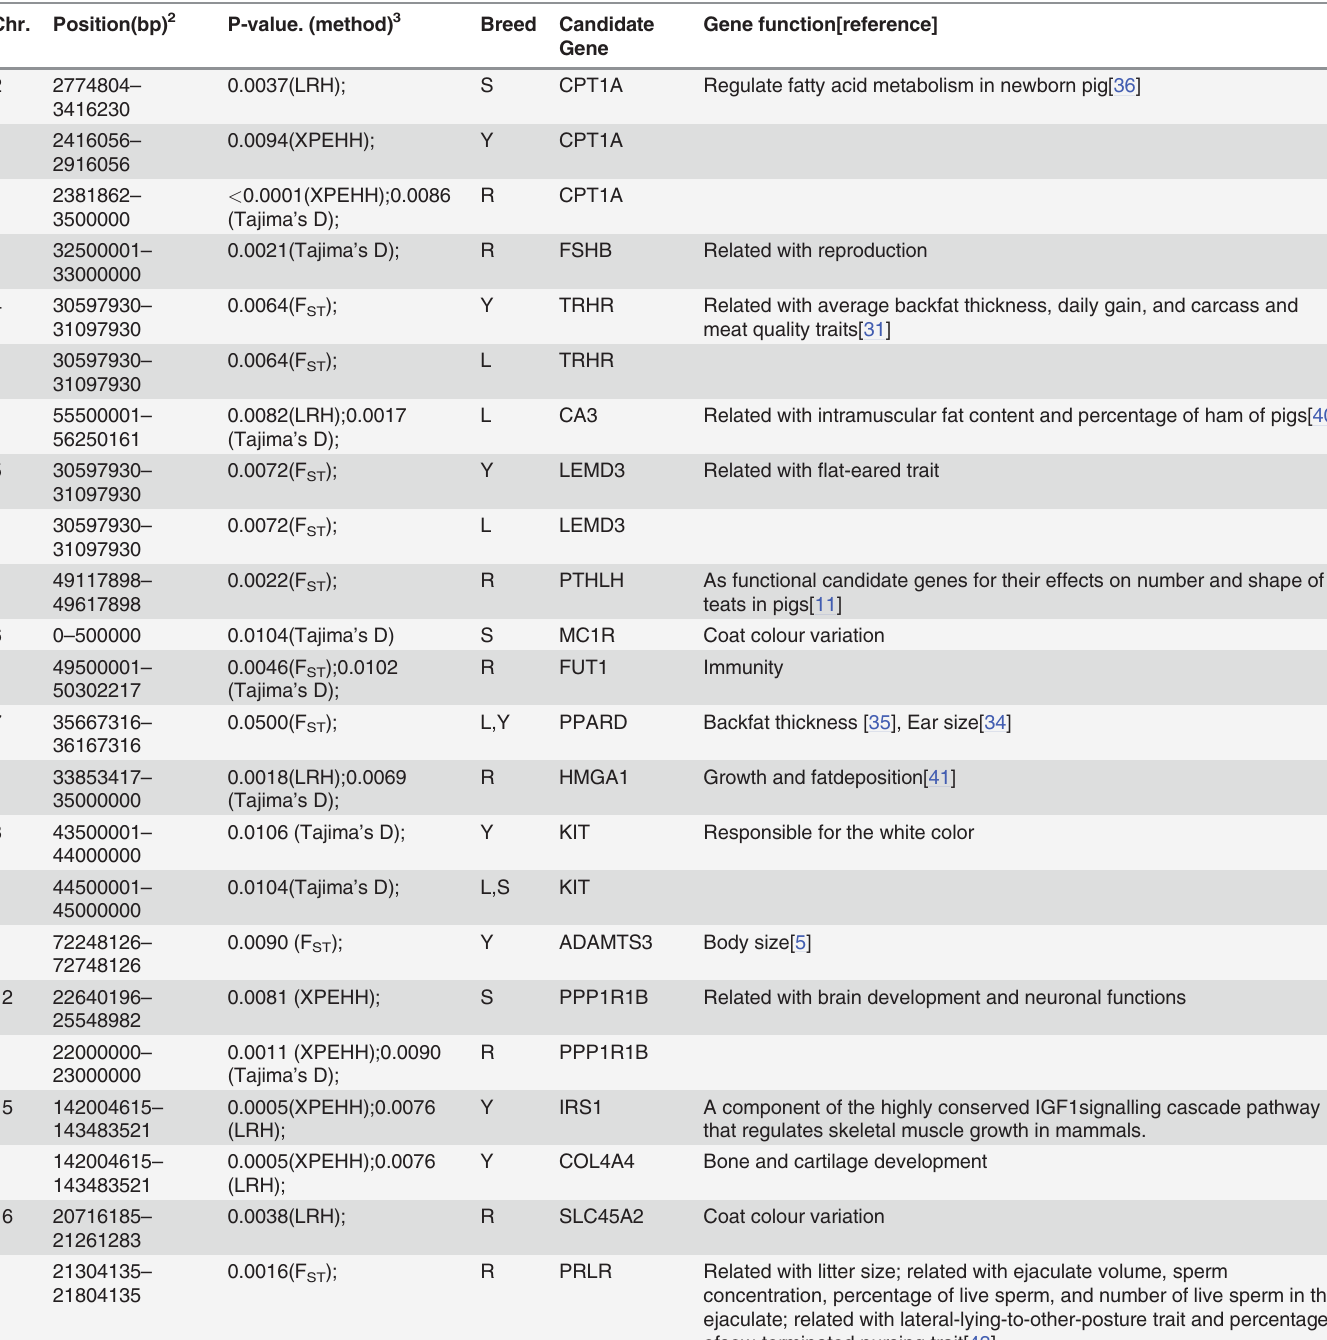
Table 4. Some Candidate genes located in or overlap with potential/candidate selection regions in four pig